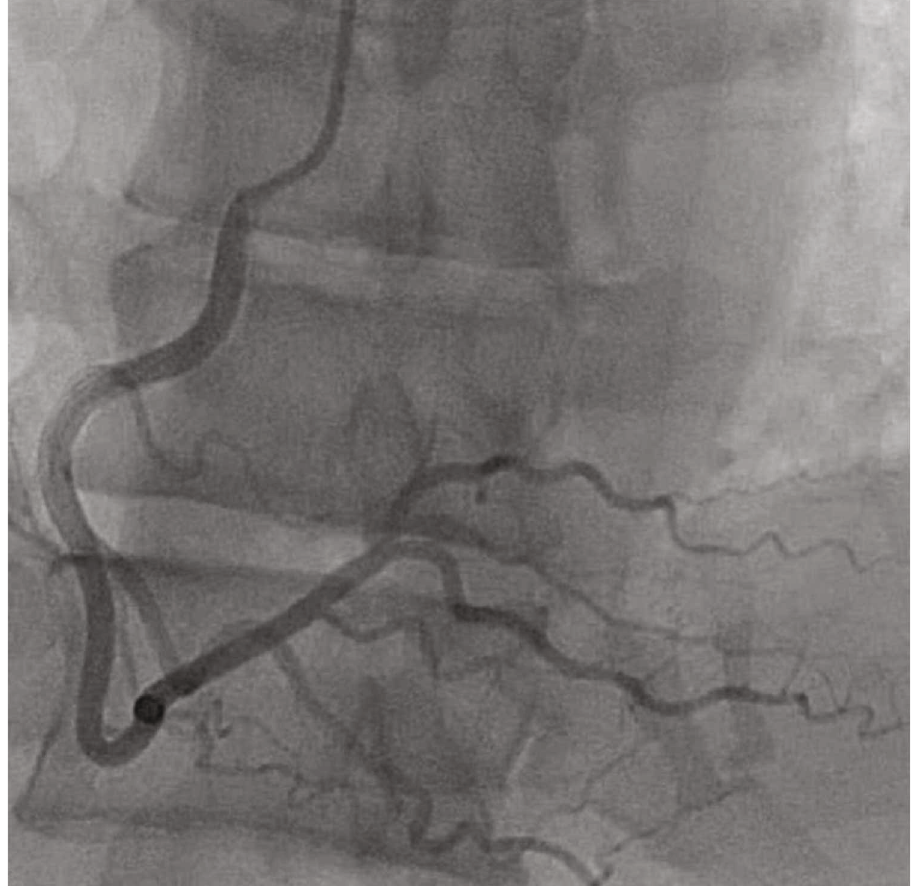
Figure 1: Left heart catheterization via the right radial approach. Selective angiograph of the right coronary artery in the left anterior oblique cranial projection revealing a medium caliber vessel angiographically free of any signi fi cant atherosclerotic